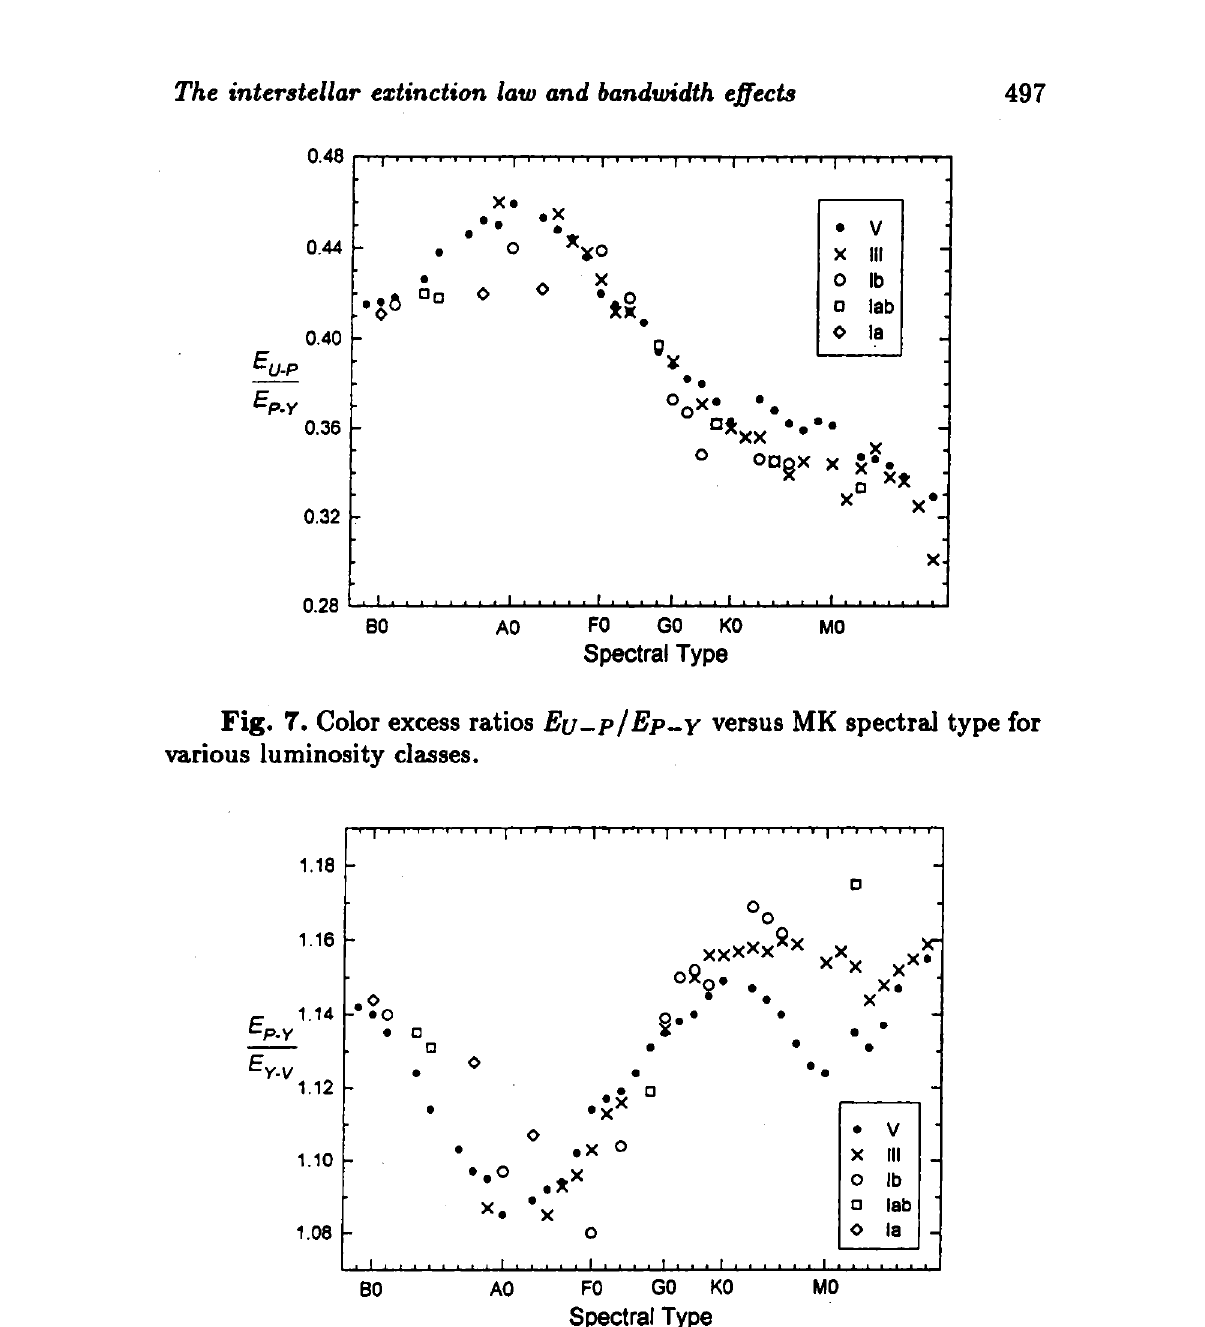
Fig. 8. Color excess ratios Ερ-γ/Εγ-ν versus MK spectral type for various luminosity